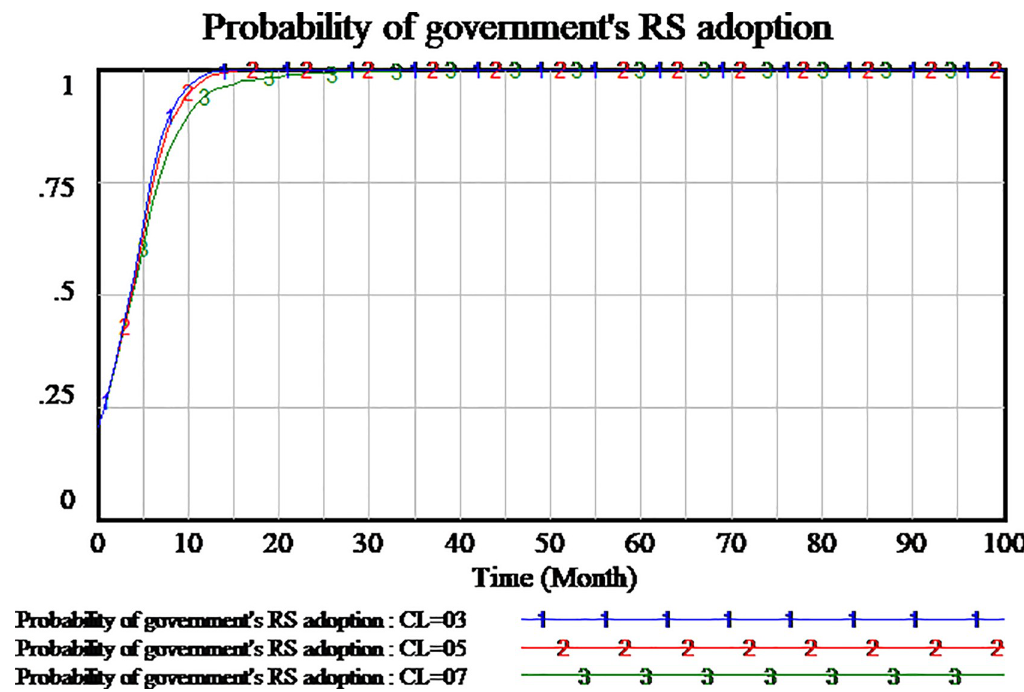
Fig 20. Impact of different cost of low-quality service on